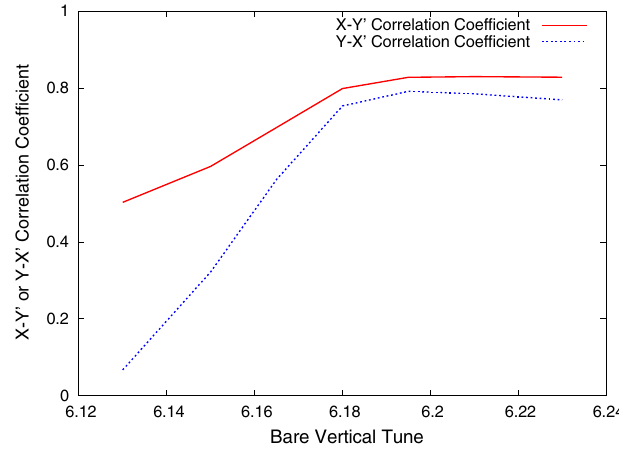
FIG. 8. Correlation coefficients following injection for x - y 0 (red) and y - x 0 (blue) versus Q y .